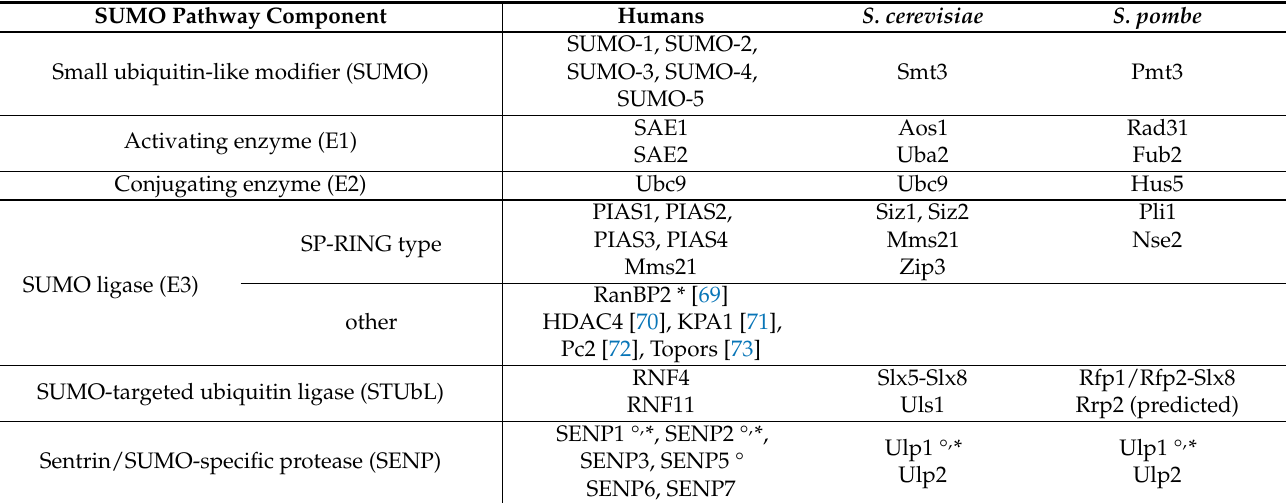
Table 1. Players of the SUMO pathway in humans, Saccharomyces cerevisiae and Schizosaccharomyces pombe . SUMO Pathway Component